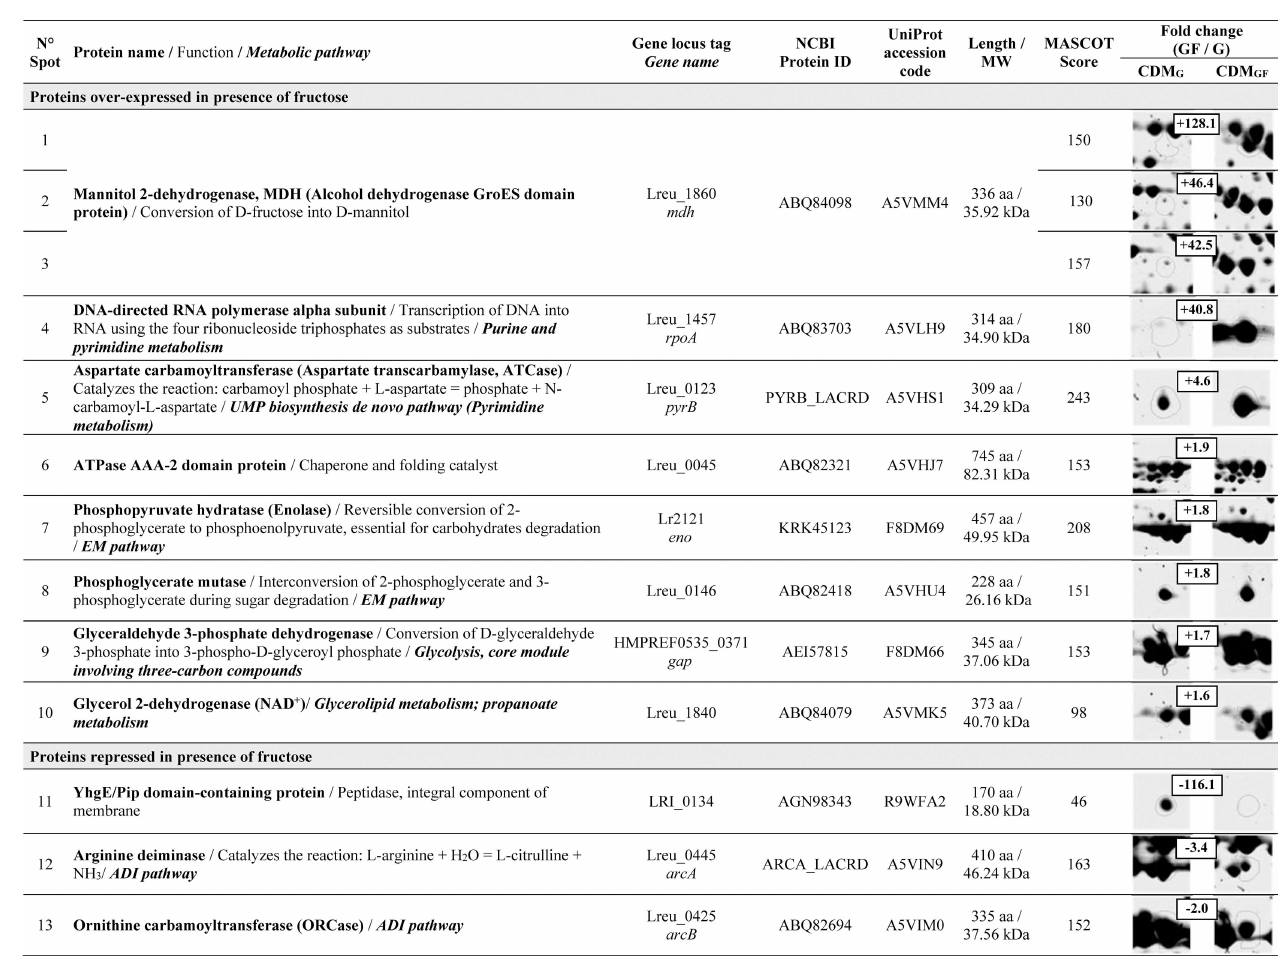
Fig 6. Proteins of Lactobacillus reuteri CRL 1101 over-expressed or repressedat 8 h of incubation in the presence of fructose, separated by 2DE and identified by Maldi